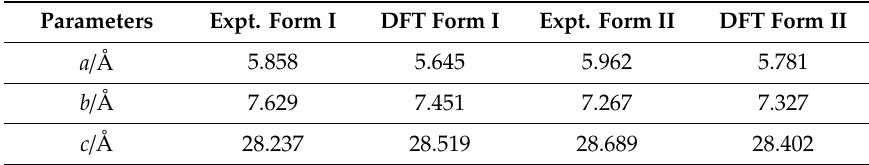
Table 2. The observed and calculated lattice constants (Å) of forms I and II under standard